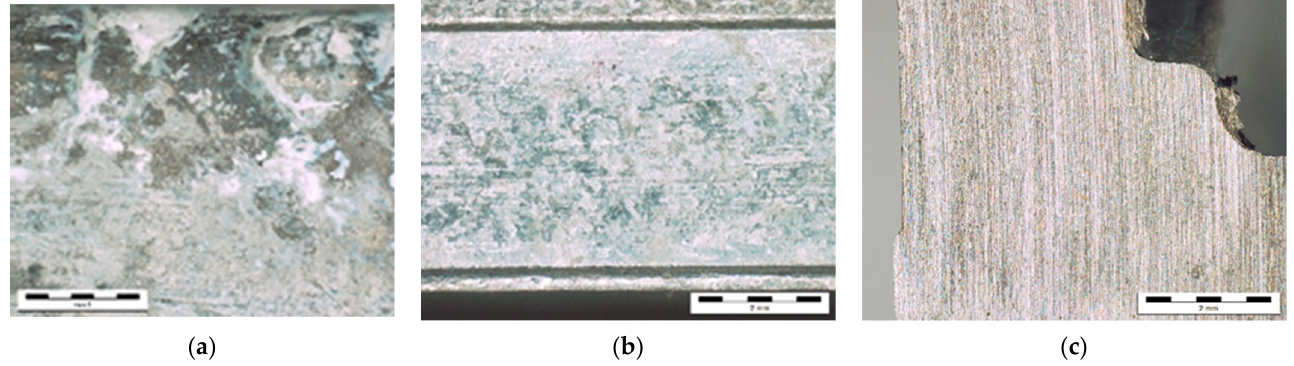
Figure 1. Stereo-microscope images of the degraded surface of the Al–Si alloy ( a ), undegraded area ( b ), and cross-section of the freshly cut casting. ( c ) Magnification: 20×.